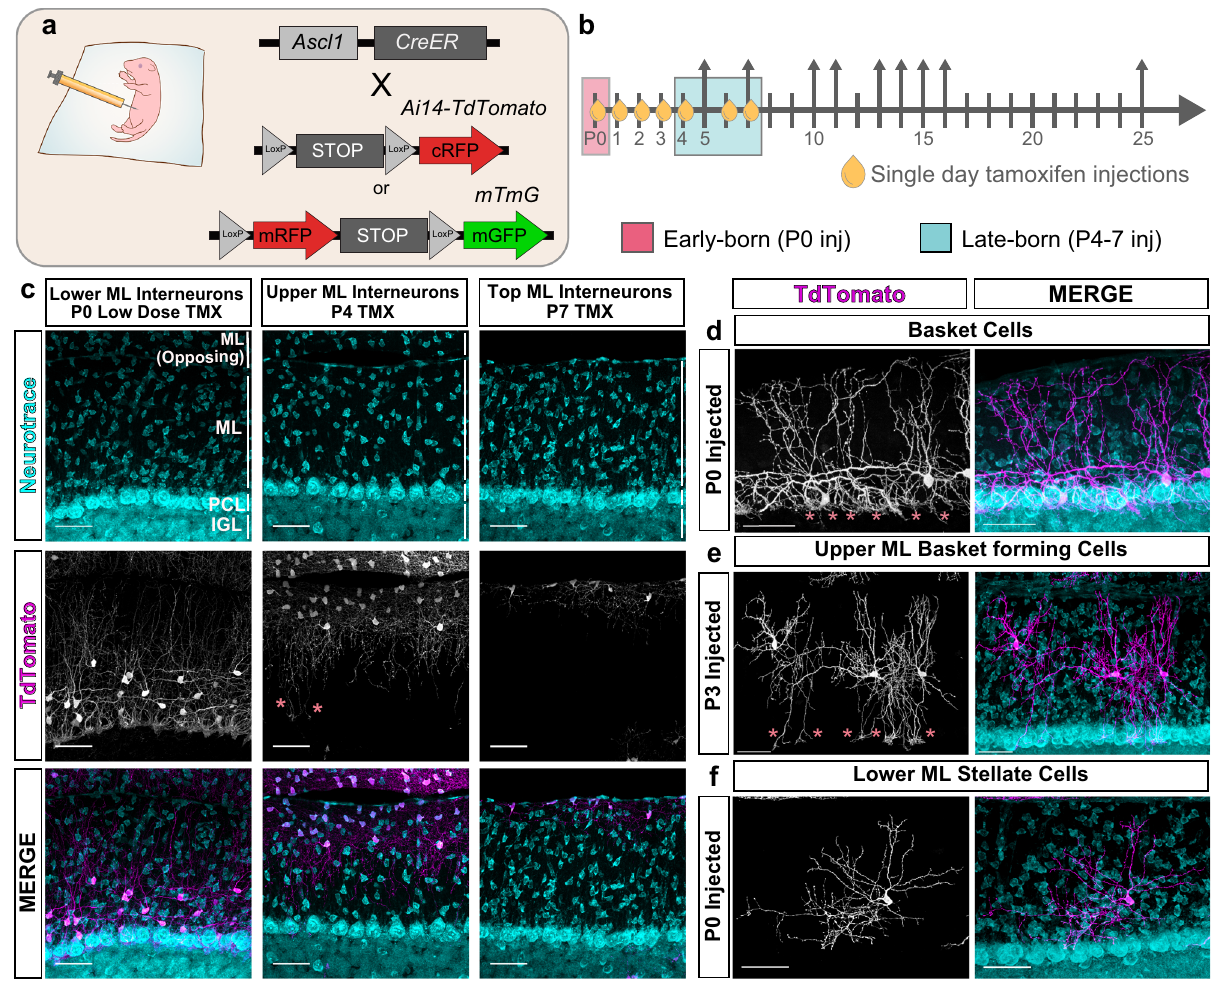
Fig. 7 Birthdate-dependent targeting of morphological MLI subtypes by Ascl1-CreER. a MLI labeling strategy by tamoxifen (TMX) inducible Ascl1-CreERT2 and fl uorescent Cre reporters, Ai14-TdTomato (cytosolic) or mTmG (membrane-targeted). b Schematic for TMX-induced subtype-enriched MLI labeling, with postnatal time points of single dose TMX injections (oil droplets) and collection (arrows). Injection at P0 predominantly labels BC populations (early-born, pink), while P4-7 injections label SCs in the upper ML (late-born, teal). c Confocal images of cerebellar sections from P25 Ascl1-CreER; Ai14-TdTomato mice with TMX induction at P0, P4, or P7. d P0-induced BCs in the lower ML. e P3-induced SCs in the mid-upper ML with descending basket terminals. Pink asterisks denote basket formations enveloping PC soma in c – e . f P0-induced non-basket forming SC in the lower ML. Representative images were taken at P25. N = 3 – 5 animals per injection time point ( c – f ). Scale bars are 50 µ